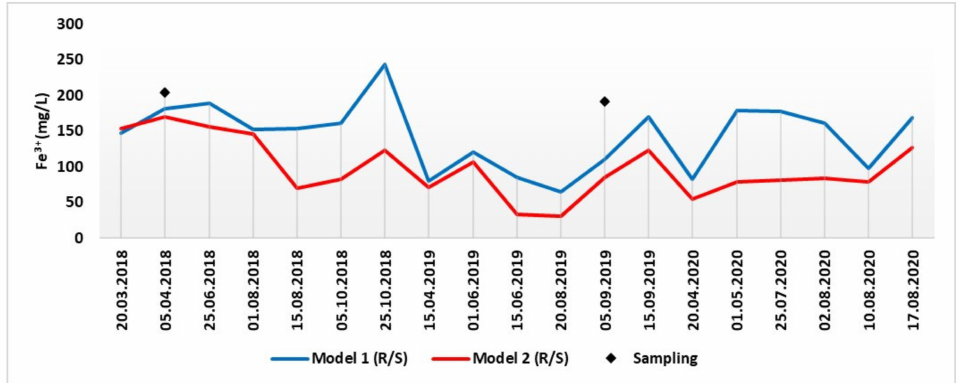
Figure 19. Development of Fe 3+ concentration over time in the Klärteich See.